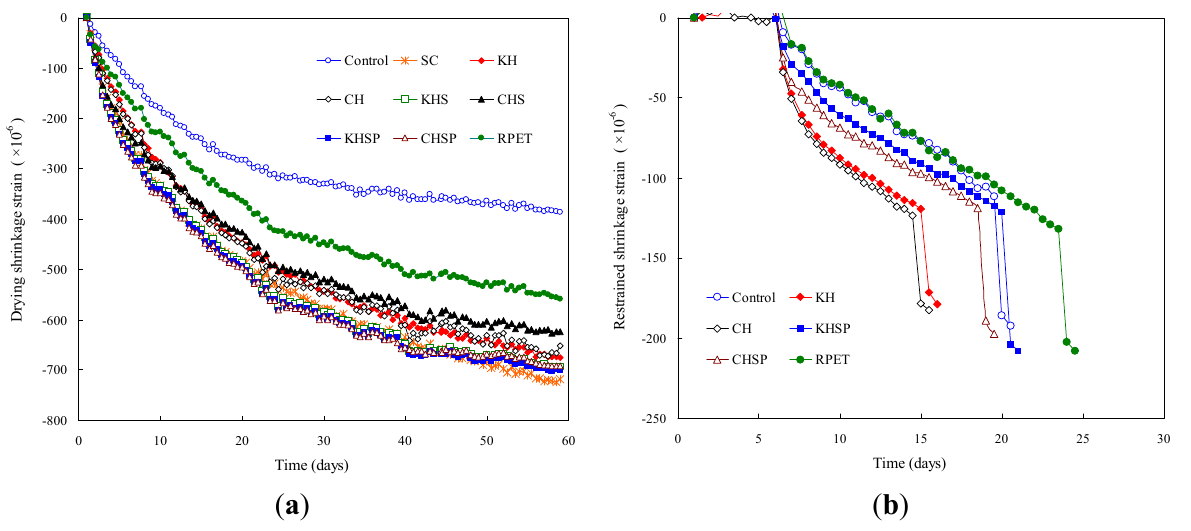
Figure 13. Free and restrained drying shrinkage strain test results ( a ) Free drying shrinkage strain results and ( b ) Restrained drying shrinkage strain and cracking